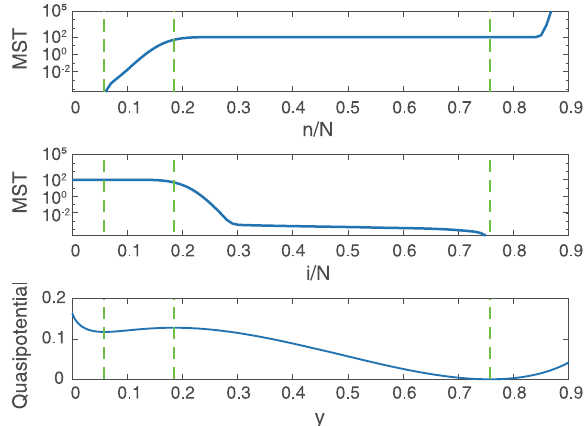
FIG. 8. Top panel: mean switch passage time T n low-state stable point i (cid:3) and various end points n . X label: relative percentage of n to the total number N . Y label: mean switch time (in logarithmic scale). Middle panel: The mean switch time T n (cid:3) for different start point i with fixed n (cid:3) as the on -state stable point. X label: relative percentage of i to the total number N . Y label: mean switch time (in logarithmic scale). Bottom panel: quasi- potential landscape of the system. Green lines indicate the position of the low steady state, saddle point, and high steady state. The parameters are set according to the N ¼ 1000 case in Sec. I of the Supplemental Material